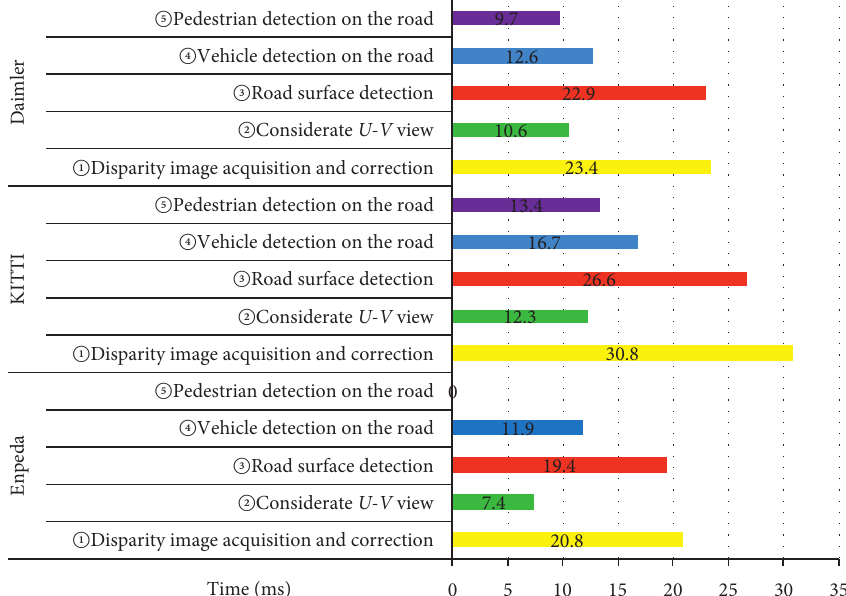
Figure 13: The real-time analysis result of three standard